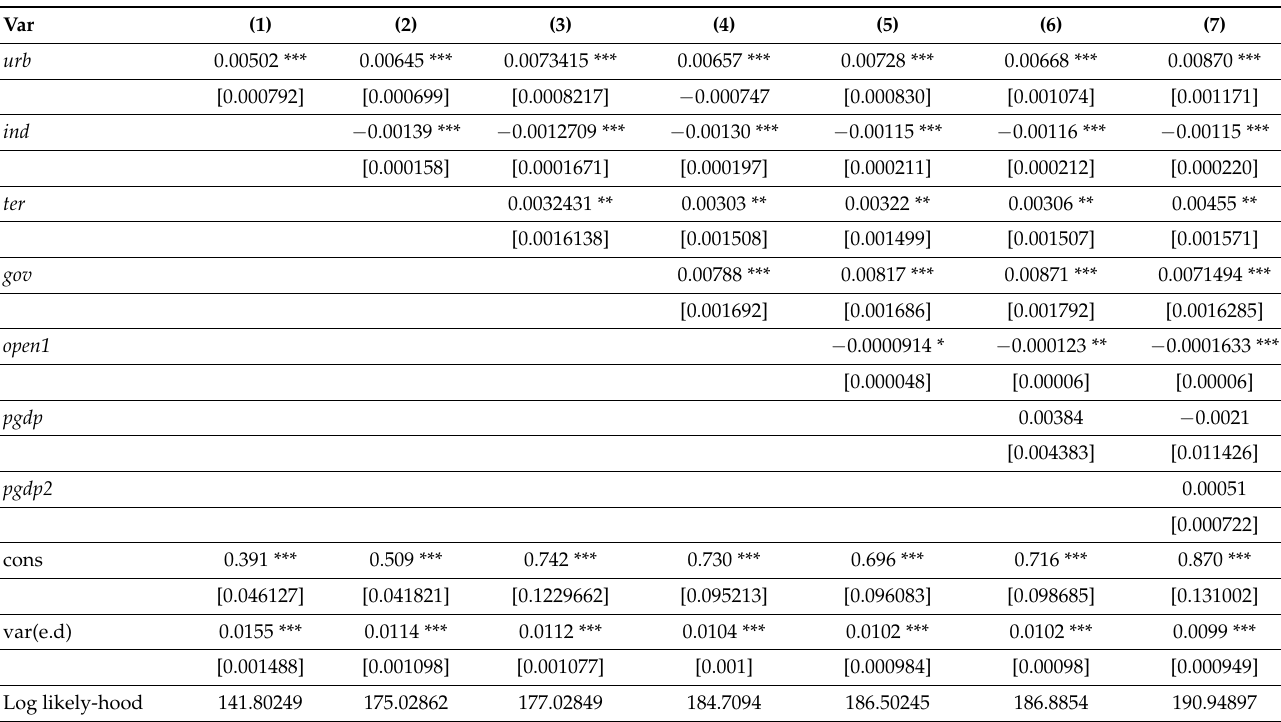
Table 6. Tobit regression